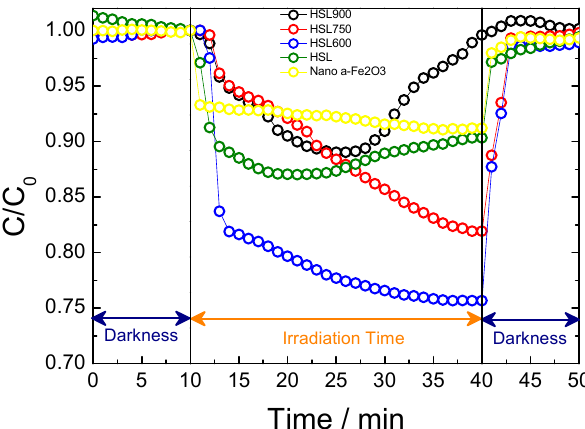
Figure 5. NO gas concentration profile evolution measured during the photochemical test, for α -Fe 2 O 3 pattern and HSL samples.